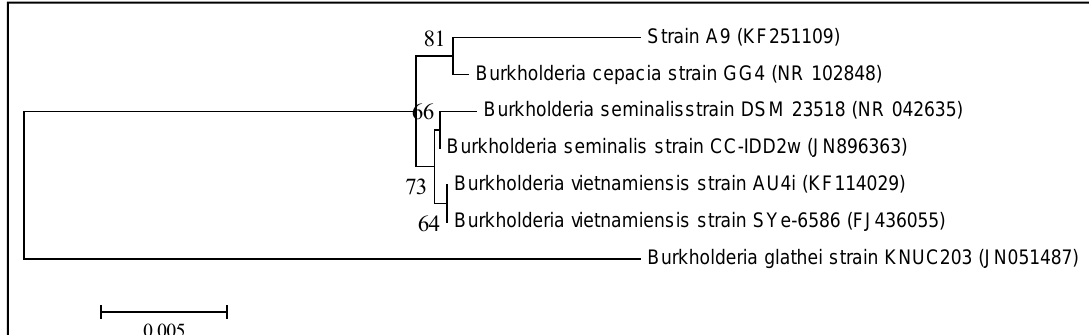
Figure 2. 16S rDNA-based phylogenetic tree showing the phylogenetic position of strain A9 with its closest relatives. A total of 1,416 unambiguously aligned 16S rDNA nucleotides were analyzed using Mega 5.2. The horizontal bar at the bottom represents evolutionary distance as 0.005 changes per nucleotide position, determined by measuring the lengths of the horizontal lines connecting the species. Burkholderia glathei strain KNUC203 was used as the outgroup. Numbers in parentheses are GenBank accession numbers.